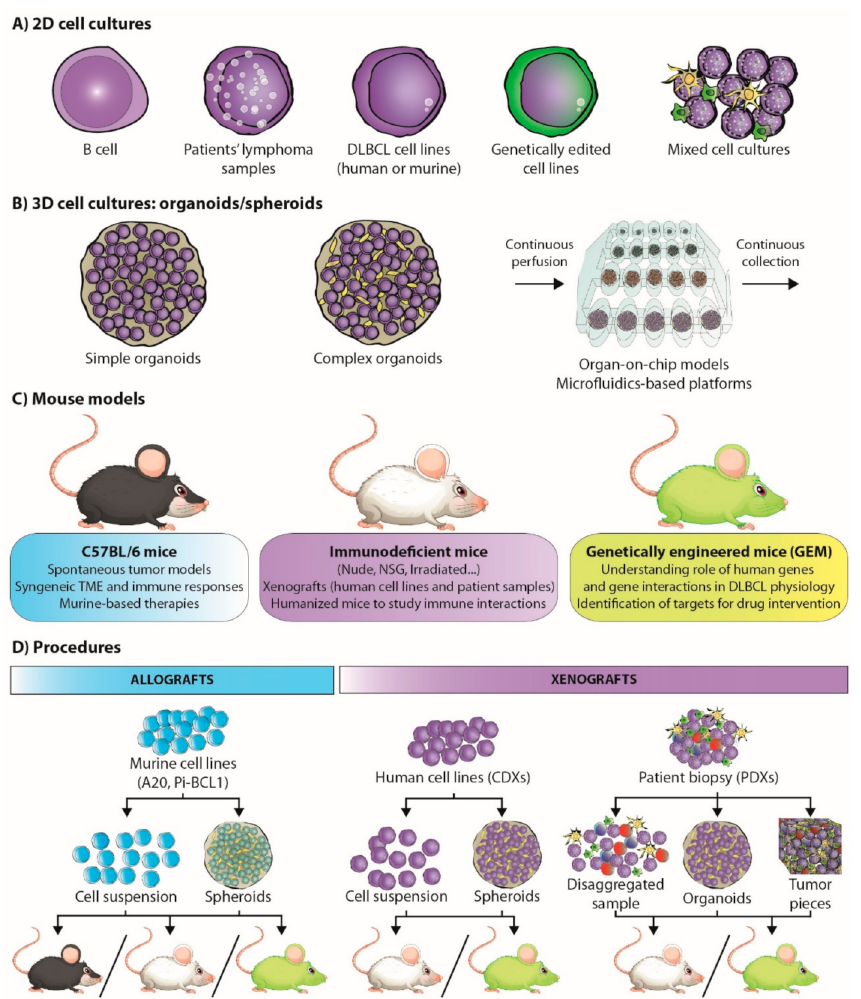
Figure 2. Preclinical models in lymphoma research and procedures. Research models in B-cell lymphomas include: ( A ) two-dimensional (2D) cell cultures comprising B-cells, patient lymphoma samples, DLBCL cell lines, gene edited cell lines, or mixed-cell cultures; ( B ) three-dimensional (3D) cell cultures, such as simple organoids involving a single cell type, complex organoids involving several cell types, and more complex systems, such as organ-on-chip models and microfluidics- based platforms; ( C ) mouse models, with CD57BL/6, immunodeficient, or genetically engineered mice (GEM). Their uses are summarized in the boxes below the mice. ( D ) All these elements can be combined and used to develop a variety of procedures involving cells from the same species (syngeneic allografts, left) or from different species (xenografts, right). B-cell-lymphoma-derived cell lines have been widely used in the study of